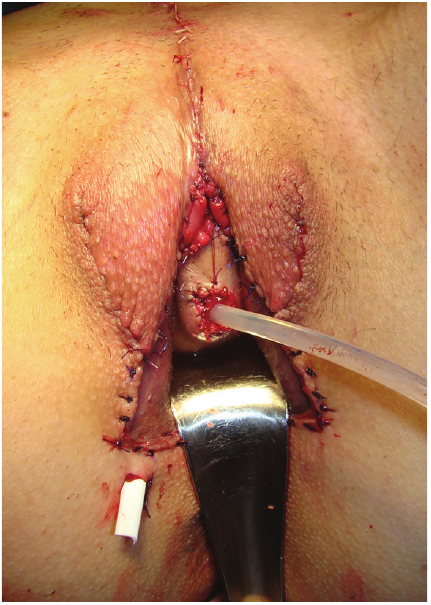
Figure 7: Outcome at the end of